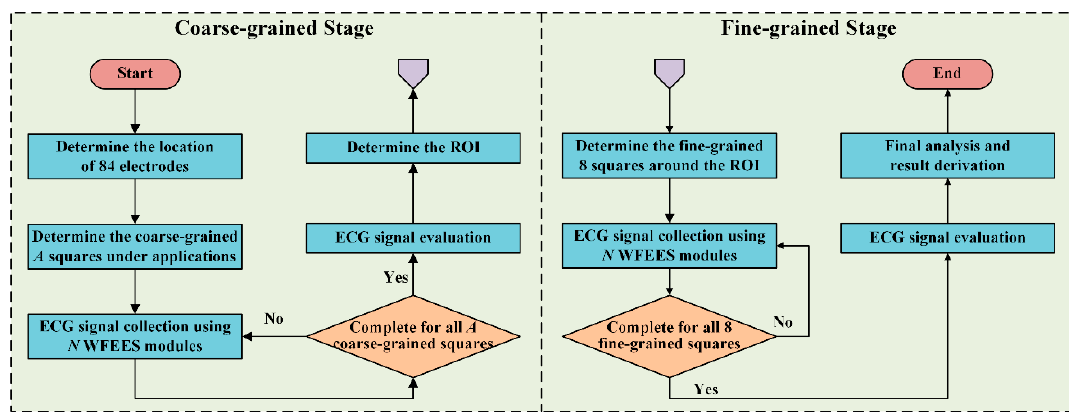
Figure 4. The block diagram of the layered ( A , N ) square-based (LANS) method, including the coarse-grained stage and the fine-grained stage.